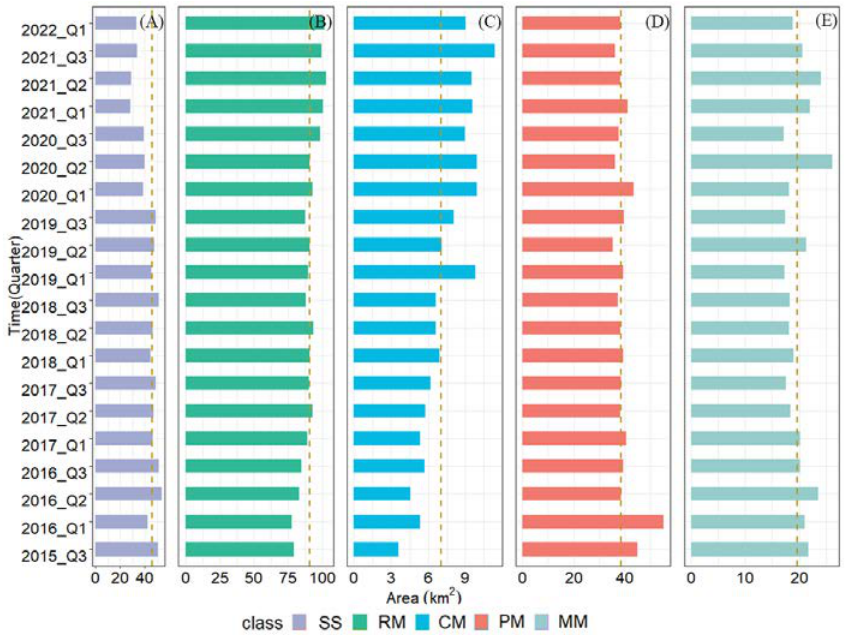
Figure 8. Plot showing seasonal variations of types of mariculture in the Zhao’an bay including Q1: spring (March–May), Q2: autumn (September–Novvember), Q3: winter (December–February). ( A